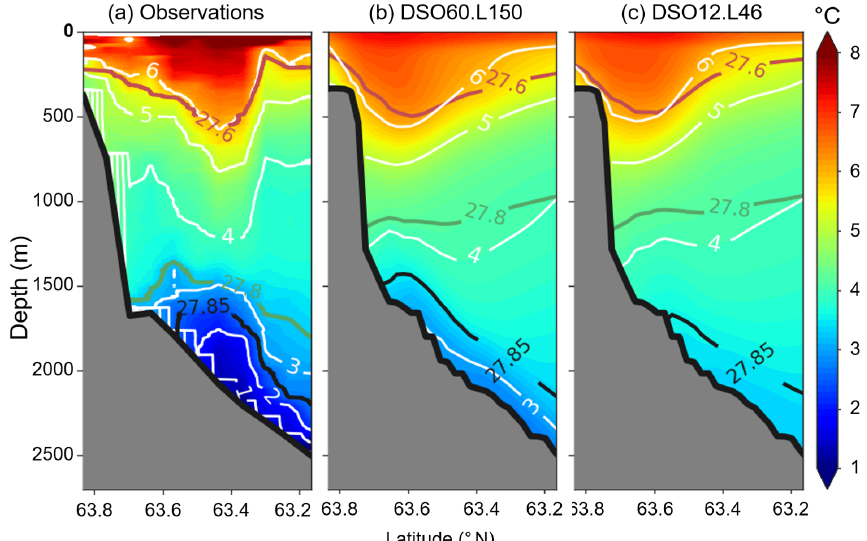
Figure 5. Potential temperature ( ◦ C) at section 29 in (a) the observations (ASOF6 section; Quadfasel, 2010), (b) the 1 / 60 ◦ , 150-level simulation (annual mean), and (c) the 1 / 12 ◦ , 46-level simulation (annual mean). Red, green, and black full lines are isopycnals 27.6, 27.8, and 27.85. White lines are isotherms in 1 ◦ C intervals. In panel (b) , section 29 is outside (100km downstream) the 1 / 60 ◦ AGRIF zoom, so the effective resolution is 1 / 12 ◦ , but the water masses acquired their properties upstream within the 1 / 60 ◦ resolution